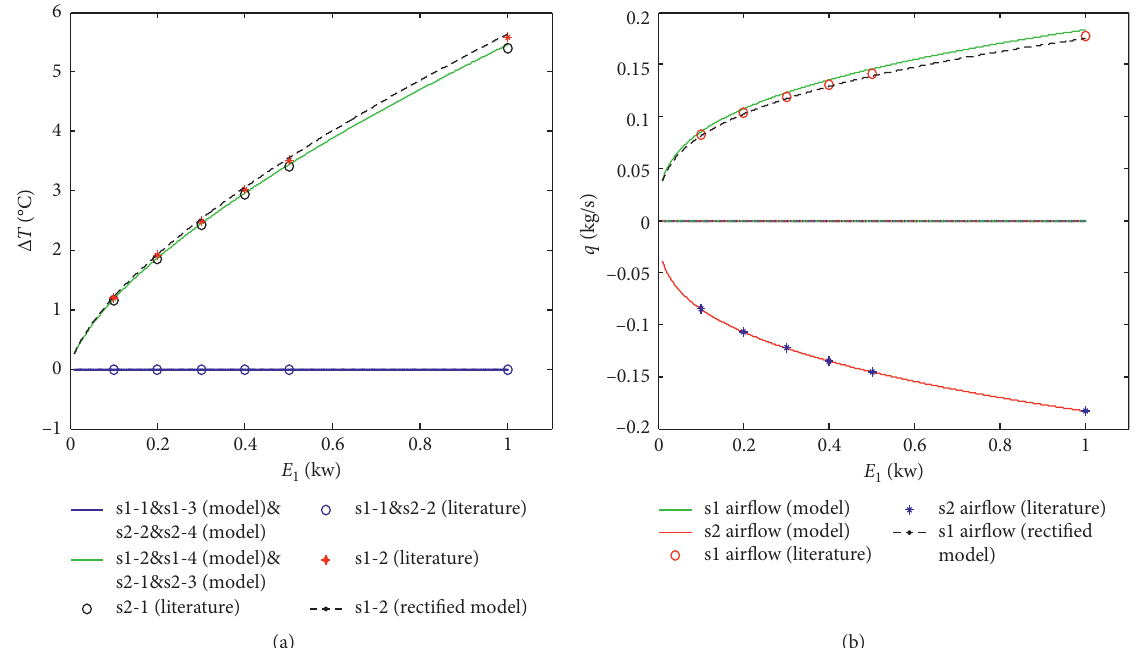
Figure 2: Modeled results validation. (a) Temperature comparison between the four-zone model and previous CFD results. (b) Mass flow rates comparison between the four-zone model and previous CFD results (S1 indicates status1/realization 1; 1, 2, etc. indicates zone serial